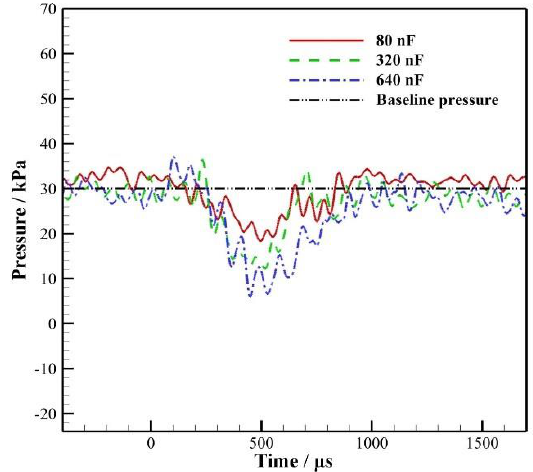
Figure 7. Change curves of ramp pressure with different discharge capacitances.